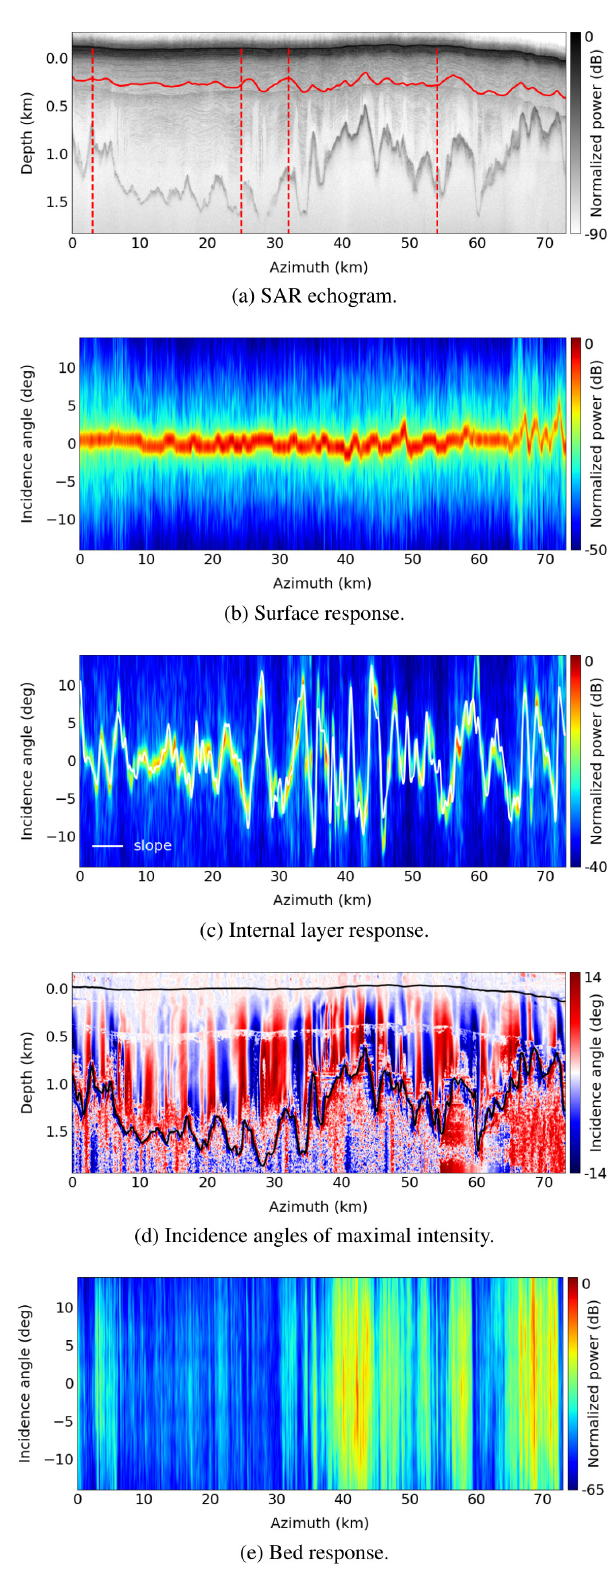
Figure 4. Backscattering characteristics of the ice sheet and bed for track